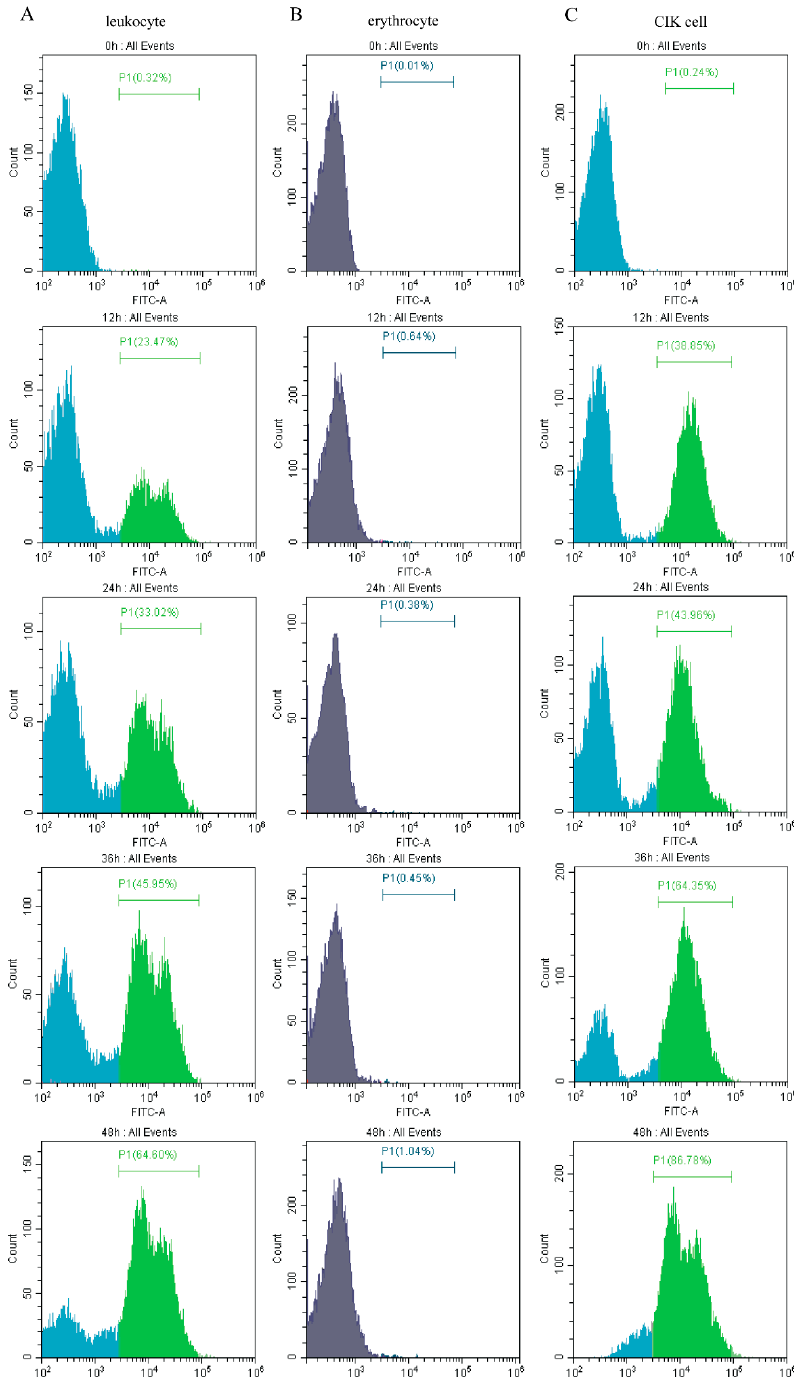
Figure 7. GCRV-positive leukocytes, GCRV-negative erythrocytes and GCRV-positive CIK cells detected by flow cytometry. Flow cytometry result from the intracellular staining for GCRV vp4 protein from GCRV infected cell (green) and control cell (blue) at 0 h, 12 h, 24 h, 36 h and 48 h post infection. The fluorescence intensity (GCRV vp4) is shown on the X-axis and cell count on the y-axis counting 10,000 cells per sample. ( A ) In ex vivo infected leukocytes, GCRV-positive rates were 0.32%, 23.47%, 33.02%, 45.95%, 64.60% at 0 h, 12 h, 24 h, 36 h and 48 h, respectively. ( B ) In ex vivo infected erythrocytes, GCRV-positive rates were 0.01%, 0.64%, 0.38%, 0.45%, 1.04% at 0h, 12h, 24h, 36h and 48h, respectively. ( C ) In infected CIK cells, GCRV-positive rates were 0.24%, 38.85%, 43.96%, 64.35%, 86.78% at 0 h, 12 h, 24 h, 36 h and 48 h,